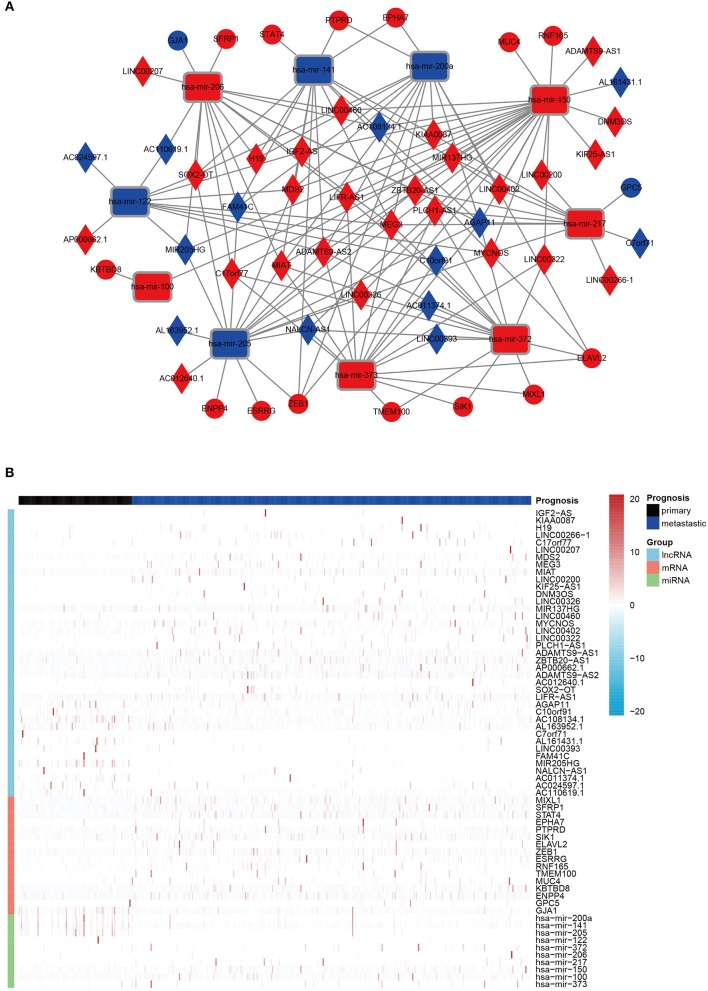
The DERNAs in ceRNA network. (A) A global view of the ceRNA regulatory network in melanoma. Rectangles, miRNAs; rhombuses, lncRNAs; circles, mRNAs; red, up-regulation; blue, down-regulation. (B) A heatmap of DE lncRNAs, miRNAs, and mRNAs in the ceRNA network.